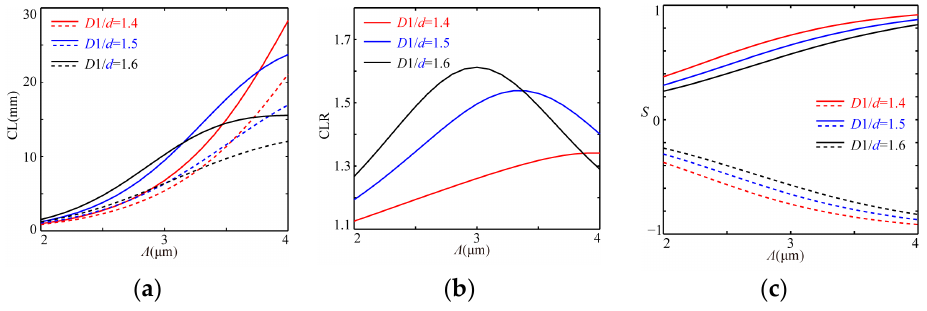
Figure 2. The variation relations of CLs ( a ), CLRs ( b ) and S s ( c ) with Λ